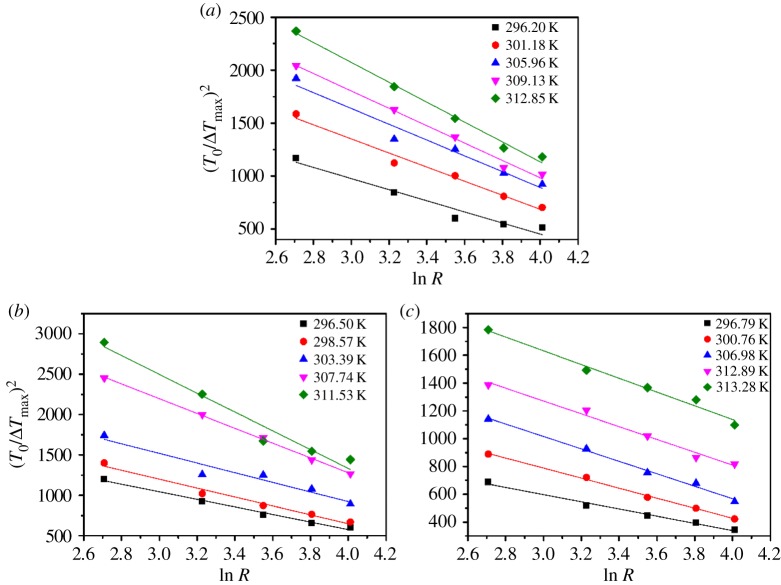
The plot of (T0/ΔTmax)2 versus ln R for borax at: (a) pH = 10.1; (b) pH = 10.3 ; (c) pH = 10.5.